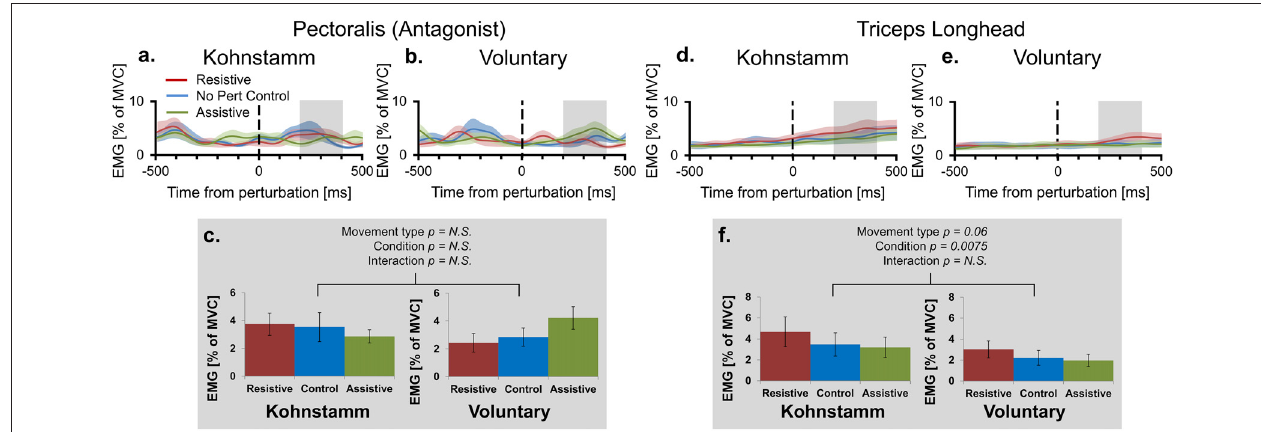
FIGURE 5 | Mean smoothed antagonist and triceps long head EMG across movement types and perturbation conditions. Smoothed group ( n = 11) antagonist EMG (% MVC) across perturbation conditions, from 500 ms prior to onset of perturbation to 500 ms post-perturbation, for Kohnstamm (A) and Voluntary movements (B) . Mean antagonist EMG (200–400 ms post-perturbation) showed there were no differences across movement types and perturbation conditions (C) . Smoothed group ( n = 9) triceps long head EMG (% MVC) across perturbation conditions for Kohnstamm (D) and Voluntary movements (E) . Mean triceps long head EMG (200–400 ms post-perturbation) showed that this muscle was not more active during Voluntary than Kohnstamm movements (F) . There was a trend in the other direction. EMG increased in the Resistive perturbation condition and decreased in the Assistive perturbation condition, relative to the No perturbation control condition. This change in EMG was significant across the two types of